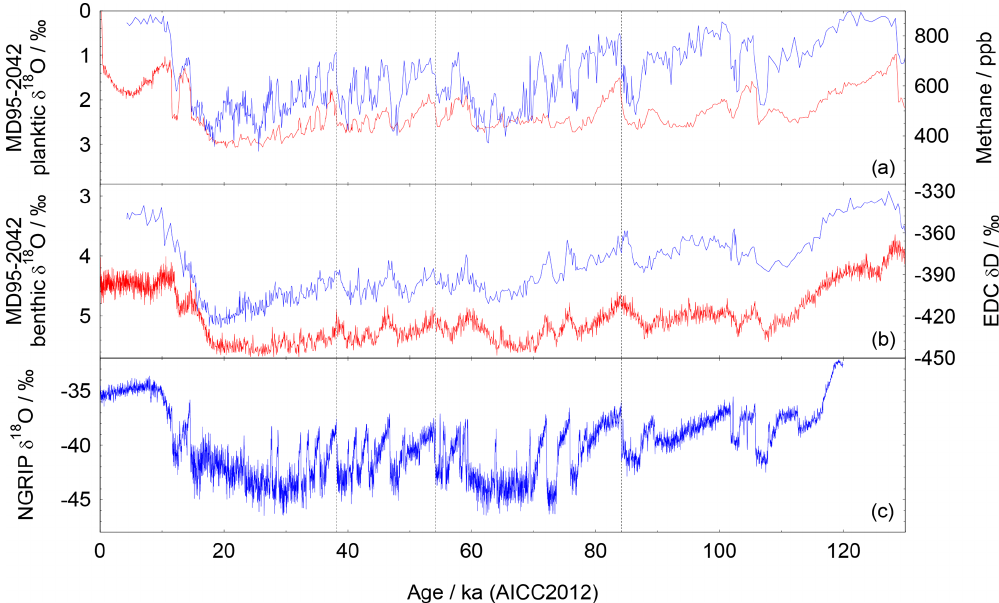
Figure 6. Sharp millennial-scale features in the last glacial cycle. (a) Planktonic δ 18 O (blue) from site MD95-2042 (Govin et al., 2014; Shackleton et al., 2000) showing the same pattern as Greenland δ 18 O; methane from the Antarctic EDC ice core (red) (Loulergue et al., 2008) showing a more subdued version of the same variability. Vertical lines mark examples of the sharp onsets of three interglacials (Greenland Interstadial (GI) 8, 14 and 21). (b) Benthic δ 18 O (blue) from site MD95-2042 (Govin et al., 2014; Shackleton et al., 2000) and the deuterium record from the Antarctic EDC ice core (Jouzel et al., 2007). (c) NGRIP δ 18 O showing the pattern of Dansgaard–Oeschger events (North Greenland Ice Core Project Members, 2004).